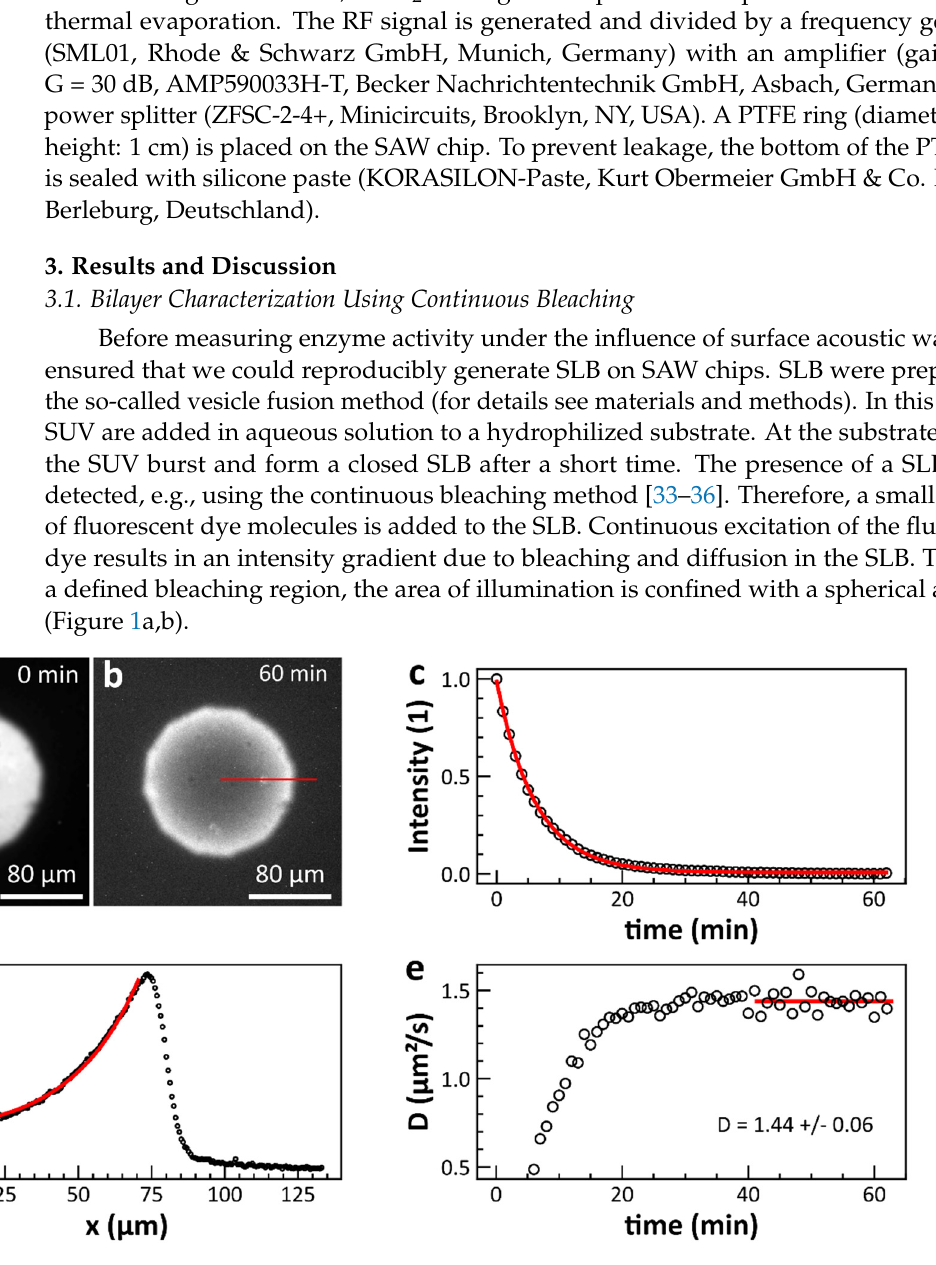
Figure 1. Detection of an SLB by the continuous bleaching method. ( a , b ) By continuous excitation of the fluorescent dye incorporated in the lipid membrane, a brightness gradient is obtained over time due to the bleaching and lateral diffusion of the individual lipids. From the bleaching constant of the dye ( c ) and the decay constant of the intensity profile ( d ) along radial directions (averaging the intensity by rotating the line shown in ( b )), the diffusion constant can be determined. ( e ) Time evolution of the diffusion constant. After complete bleaching in the center, a state of equilibrium is reached, resulting in a constant value for the diffusion constant fitted by the solid line. The circles in c-e represent the single data points. The solid lines are fits to the data according to Equations (3) and (4) in ( c ) and ( d ).